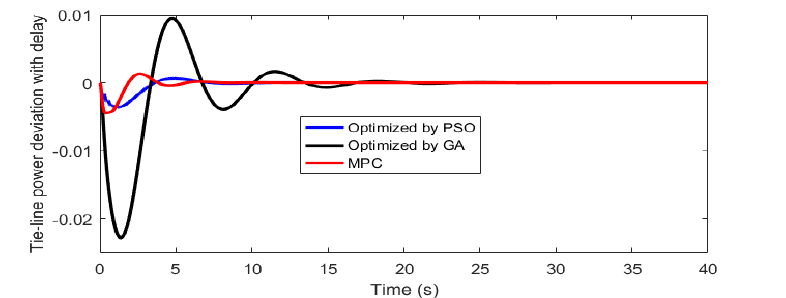
Figure 18. Tie-line power deviation for the fourth